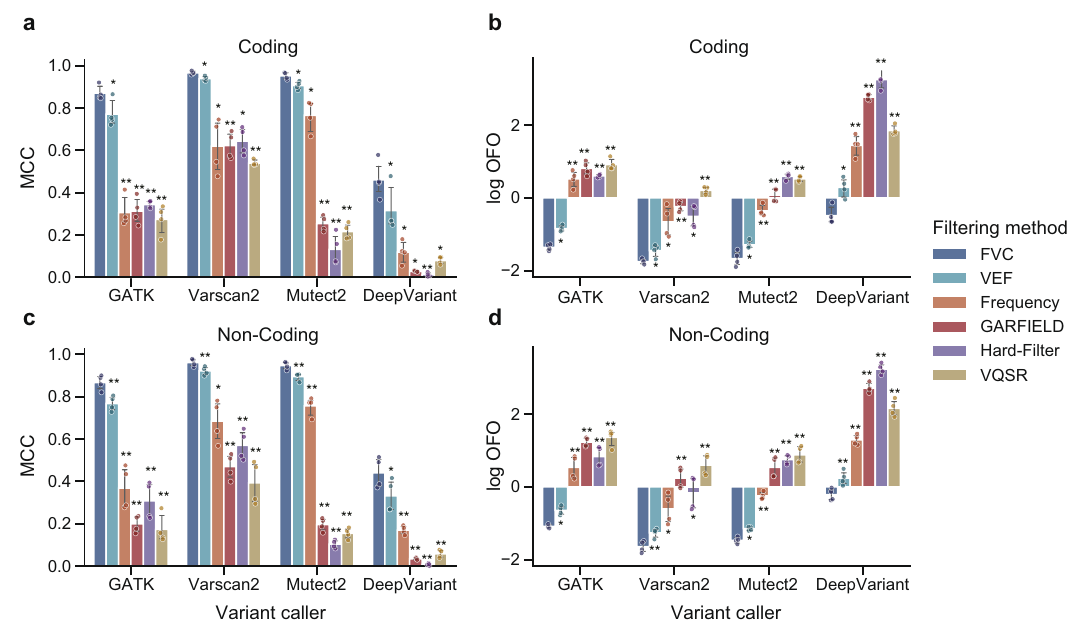
Fig. 5 The performance of different fi ltering methods when applied to coding or non-coding variants. The coding and non-coding variant calls used as testing data are derived from whole-genome sequencing data (HG001, HG003, HG004, and HG006) at 30× coverage and identi fi ed by GATK, Varscan2, Mutect2, and DeepVariant, separately. The different fi ltering methods are separately assessed on the a coding variants using MCC; b coding variants measured using OFO; c non-coding variants measured using MCC; and d non-coding variants using OFO. FVC achieves the highest MCC and the lowest log OFO when applied to both types of variants identi fi ed by GATK HaplotypeCaller, Varscan2, Mutect2, and DeepVariant. The circle indicates the metric score achieved by the fi ltering method when applied to each speci fi ed testing data. The error bar indicates the 95% con fi dence intervals ( n = 4 biologically independent samples). Asterisk denotes the signi fi cance of the comparison using a one-sided paired T-test (* p < 0.05, ** p < 0.001), where the null hypothesis is that the FVC performs no better than the compared